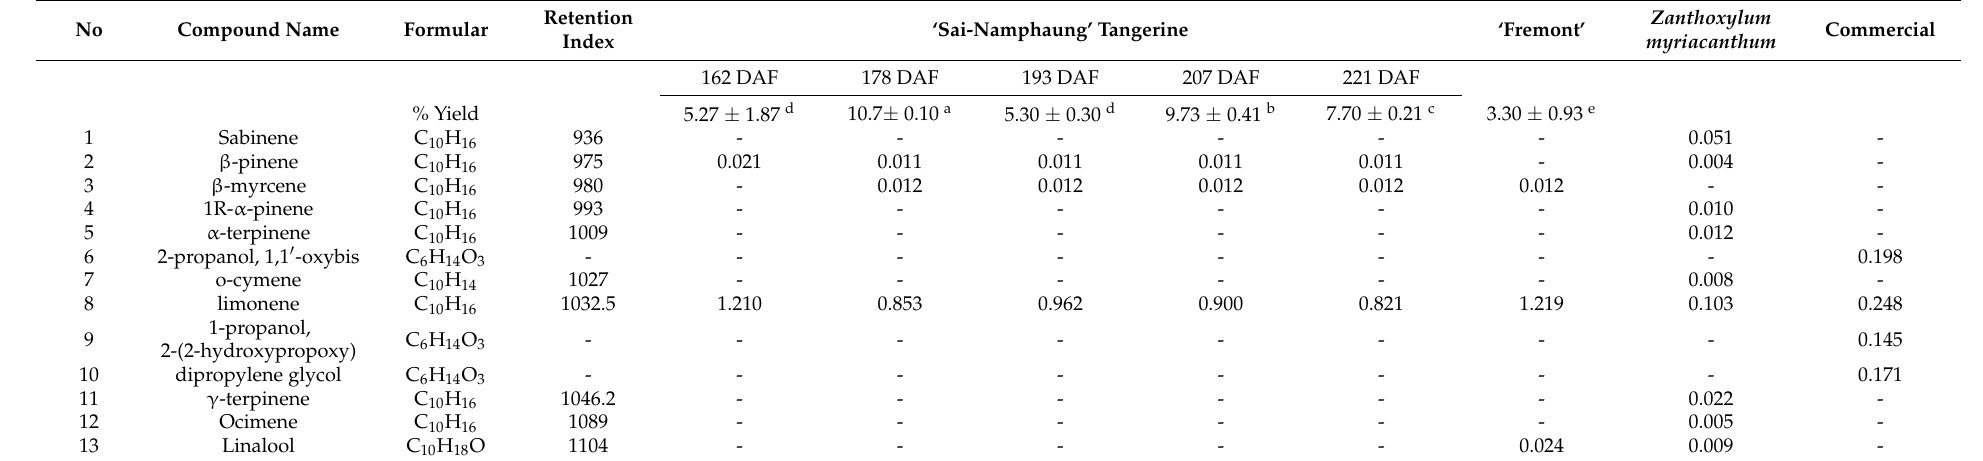
Table 1. Volatile components of essential oils from the cirtus